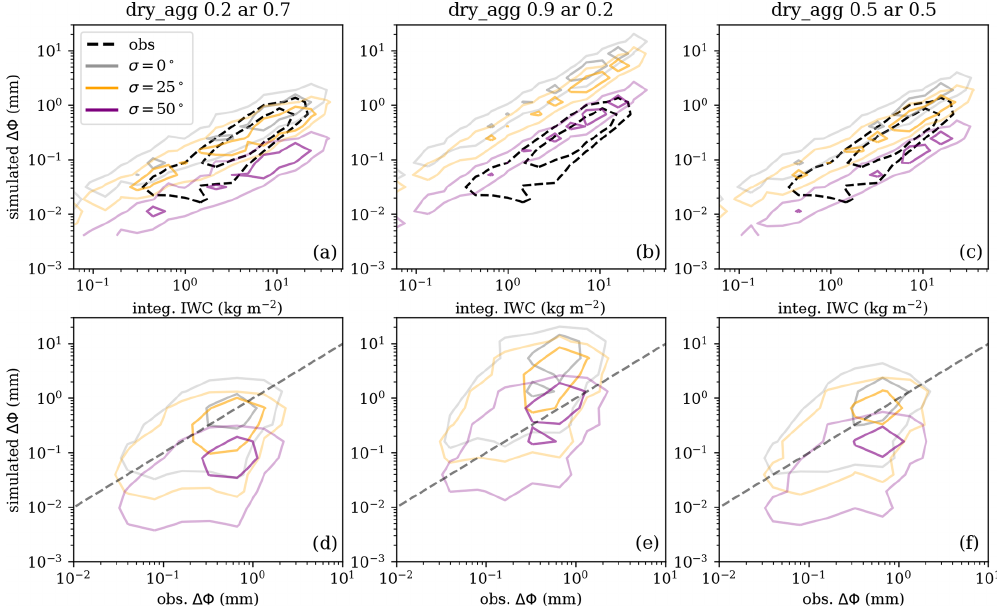
Figure 9. Results of the distributions of simulated (cid:49)(cid:56) vs. integrated IWC (a–c) and vs. the observed (cid:49)(cid:56) (d–f) compared at the same grid bins (same approach and same grid bins as in Fig. 4) and accounting for all heights. Panels (a) and (d) show the results obtained using a single type of particle at all locations and heights, where the dry aggregates have an effective density of 0.2gcm − 3 and an axis ratio of 0.7. Panels (b) and (e) correspond to results using dry aggregates with an effective density of 0.9gcm − 3 and an axis ratio of 0.2, and panels (c) and (f) correspond to results using dry aggregates with an effective density of 0.5gcm − 3 and an axis ratio of 0.5. The different colors of the contours correspond to a different standard deviation in the distribution of tilt angles, as described in the legend. The dashed contours (in panels a – c ) correspond to the observed relationships (as obtained in Sect. 3). The dashed line (in panels d – f ) indicates the perfect 1 : 1 agreement. The same color inner and outer contours represent the contour containing 30% and 70% of the data,